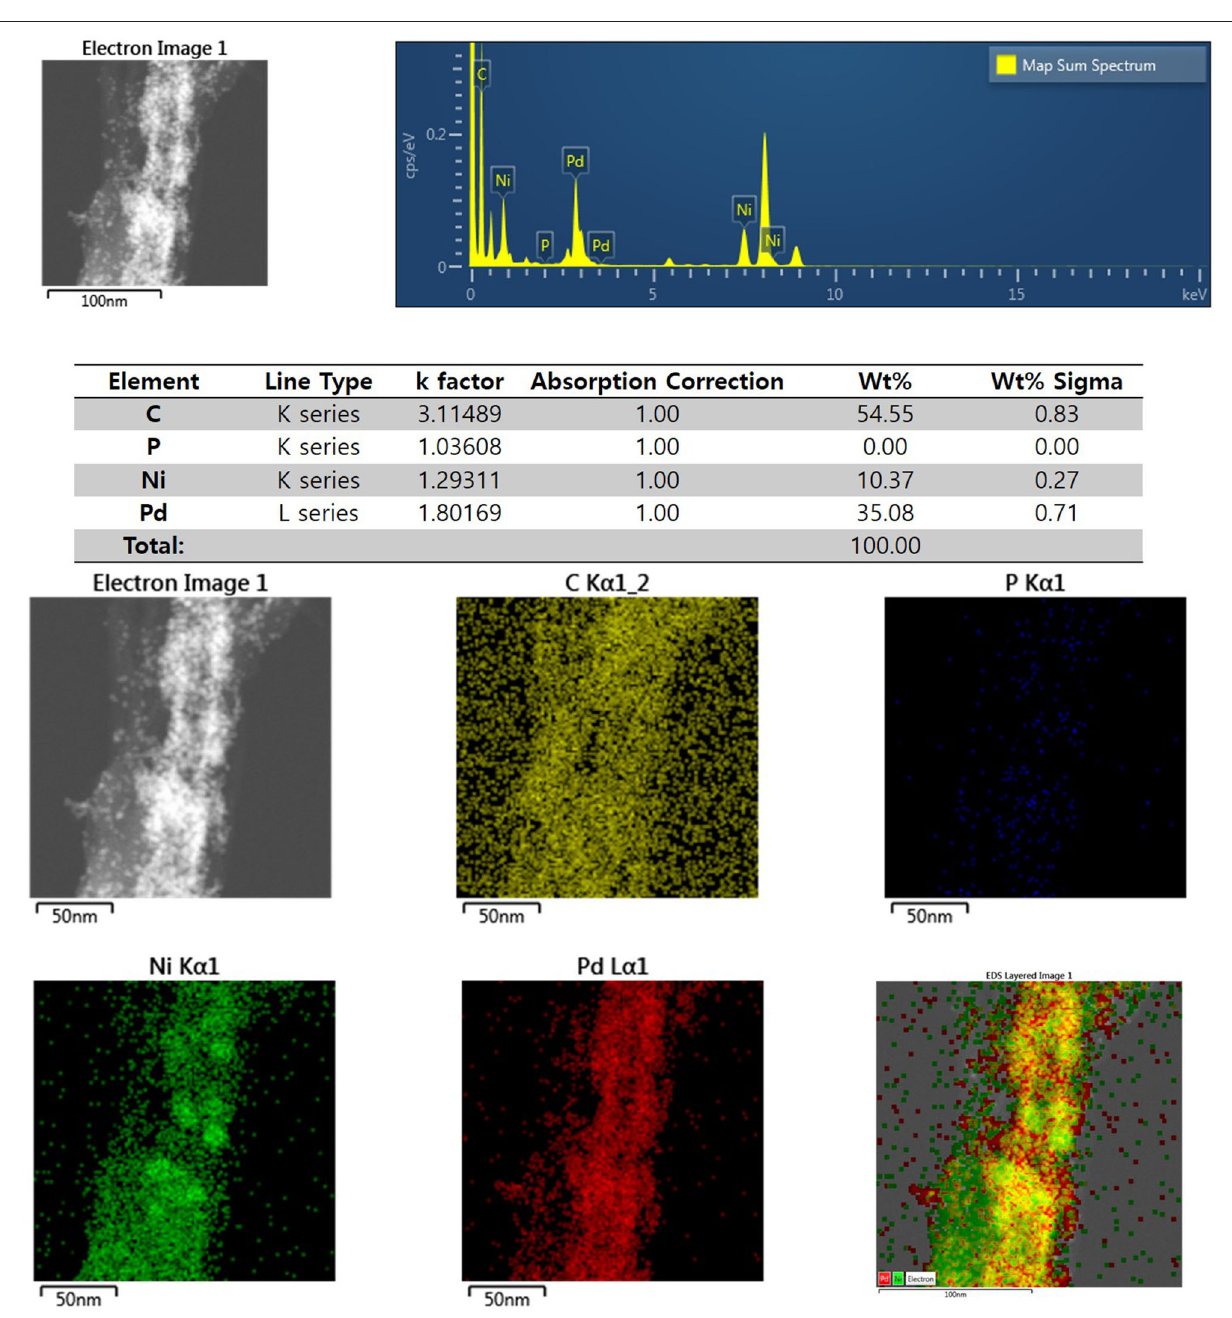
P, the intensity of Ni and Pd peaks are higher ( Figure 7 ). This allowed comparison of synthesized Ni-Pd/MWCNTs with P added Ni-Pd(P)/MWCNTs by Figure 7 , and the combination of metal alloys in the actuator produced by MWCNTs due to the dispersion and reduction of size and changes in structure characteristics of P (Basumatary et al., 2018), through XRD, TEM, and